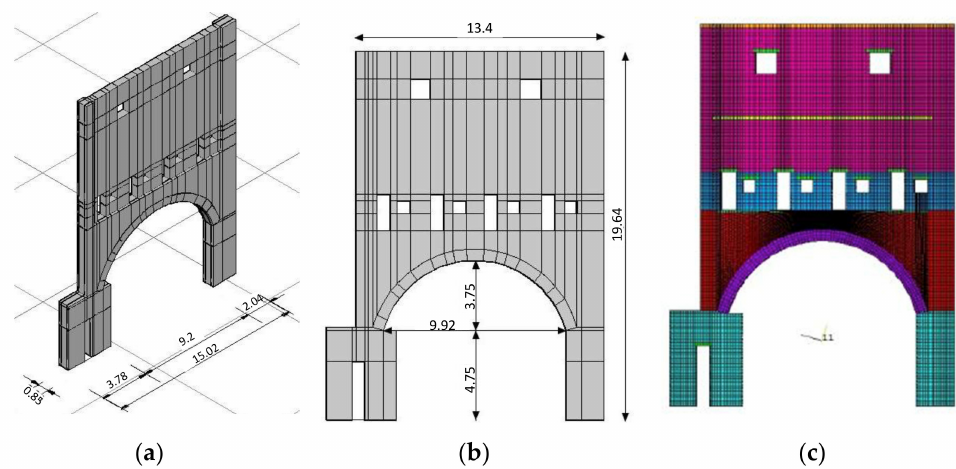
Figure 13. ( a,b ) 3D geometrical model of the Arengario; ( c ) FEM structural model. Concerning the loads, they were modelled as volumes with proper values of